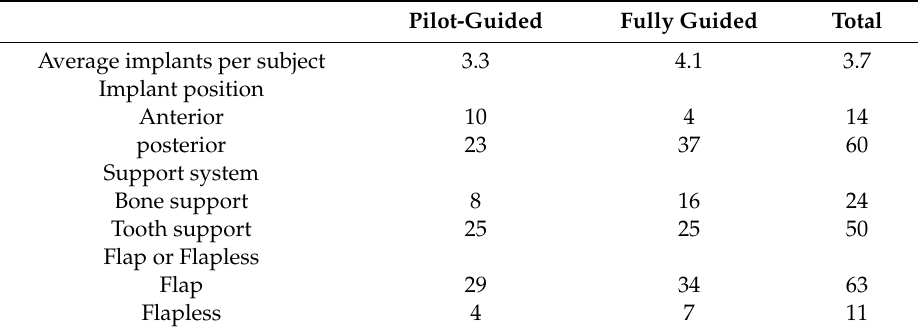
Table 1. Demographic